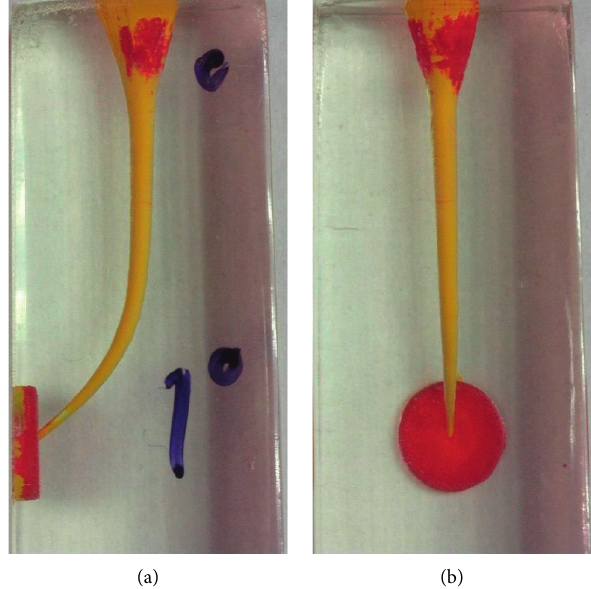
Figure 4: Endoblocks after preparation from the frontal (a) and lateral (b)